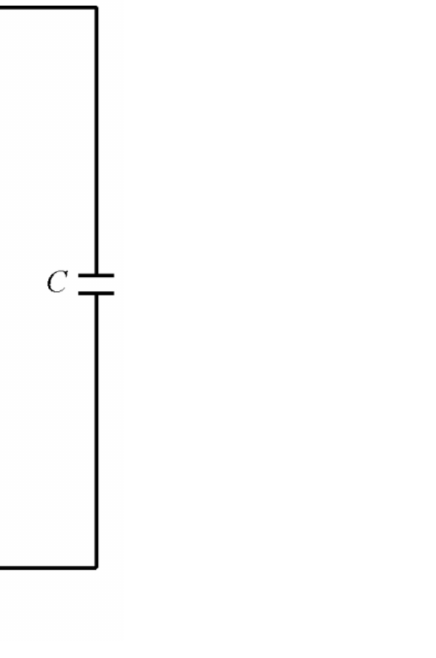
Figure 4. Diagram of the simplified circuit of the battery-pulse capacitor freewheeling